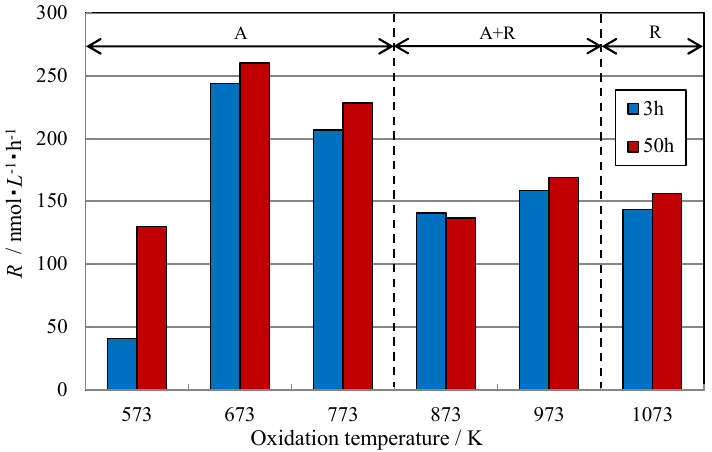
Figure 31. Degradation rate constant of M10- x K- y h